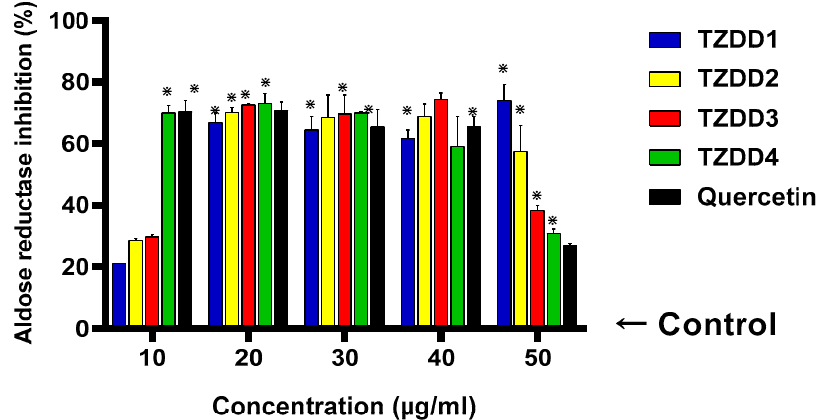
Figure 5. The inhibition of aldose reductase activity by TZD derivatives (10, 20, 30, 40, and 50 µg/mL). The results are represented in a clustered column. Data are presented as mean ± standard deviation values. The error bars correspond to the standard errors of the means, and asterisks (*) indicate a significant statistical difference relative to the control experiment ( p value ≤ 0.05). The arrow from the right pointing at the baseline at 0.0 represents the negative control, which is defined to have zero percent inhibition for the purpose of data normalization.